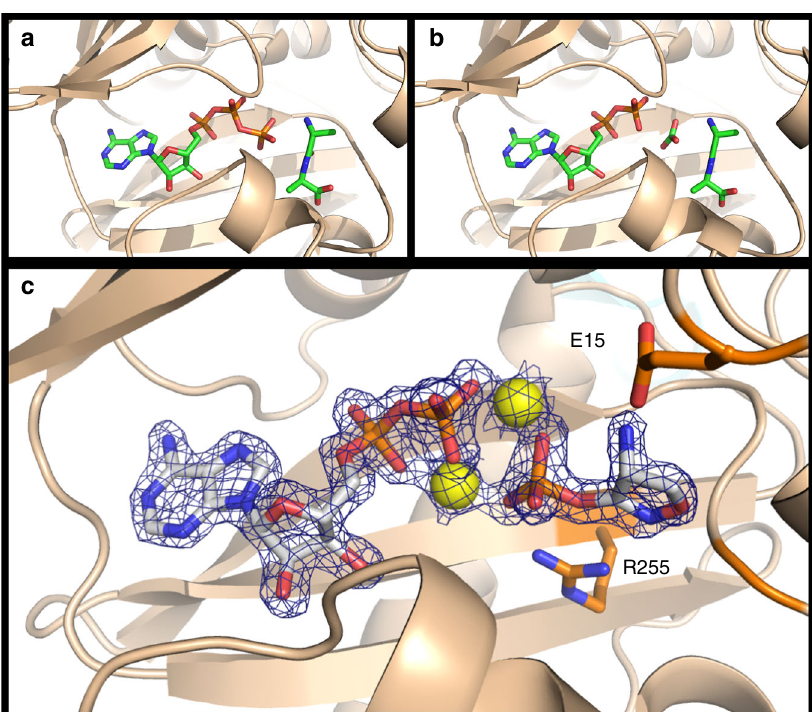
Fig. 1 Active site region of EcDdlB in different complexes. a Active site region of EcDdlB in complex with ATP and D-Ala-D-Ala, and ( b ) ADP, carbonate ion and D-Ala-D-Ala. c 2 F o - F c difference map of EcDdlB in complex with ADP, 2Mg 2+ and DCSP. Electron density at 2 σ is shown over the ADP, Mg 2+ and DCSP atoms for clarity. EcDdlB residues Glu15 (above) and Arg255 (below) are within hydrogen bonding distance to